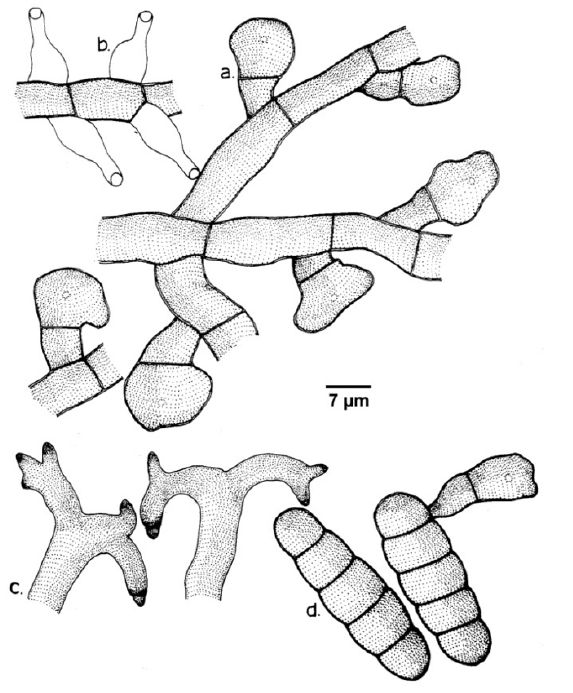
Figure 68. Meliola cymbopogonis a - Appressorium; b - Phialide; c - Apical portion of mycelial setae; d -